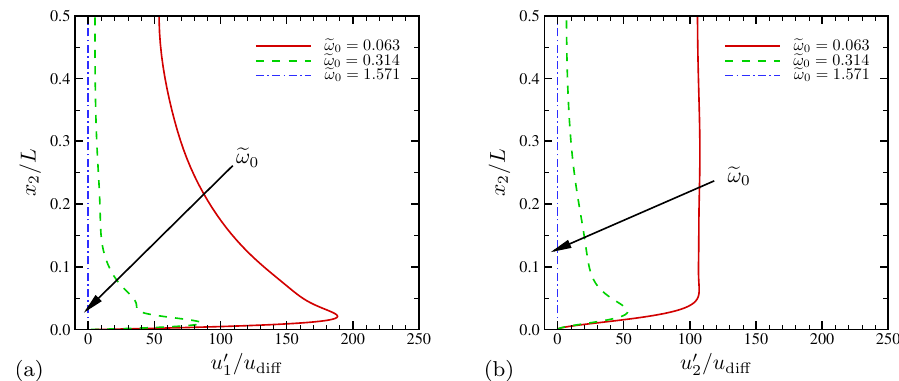
Figure 7. RMS velocity fluctuations versus wall normal coordinate for ( a ) horizontal and ( b ) wall-normal